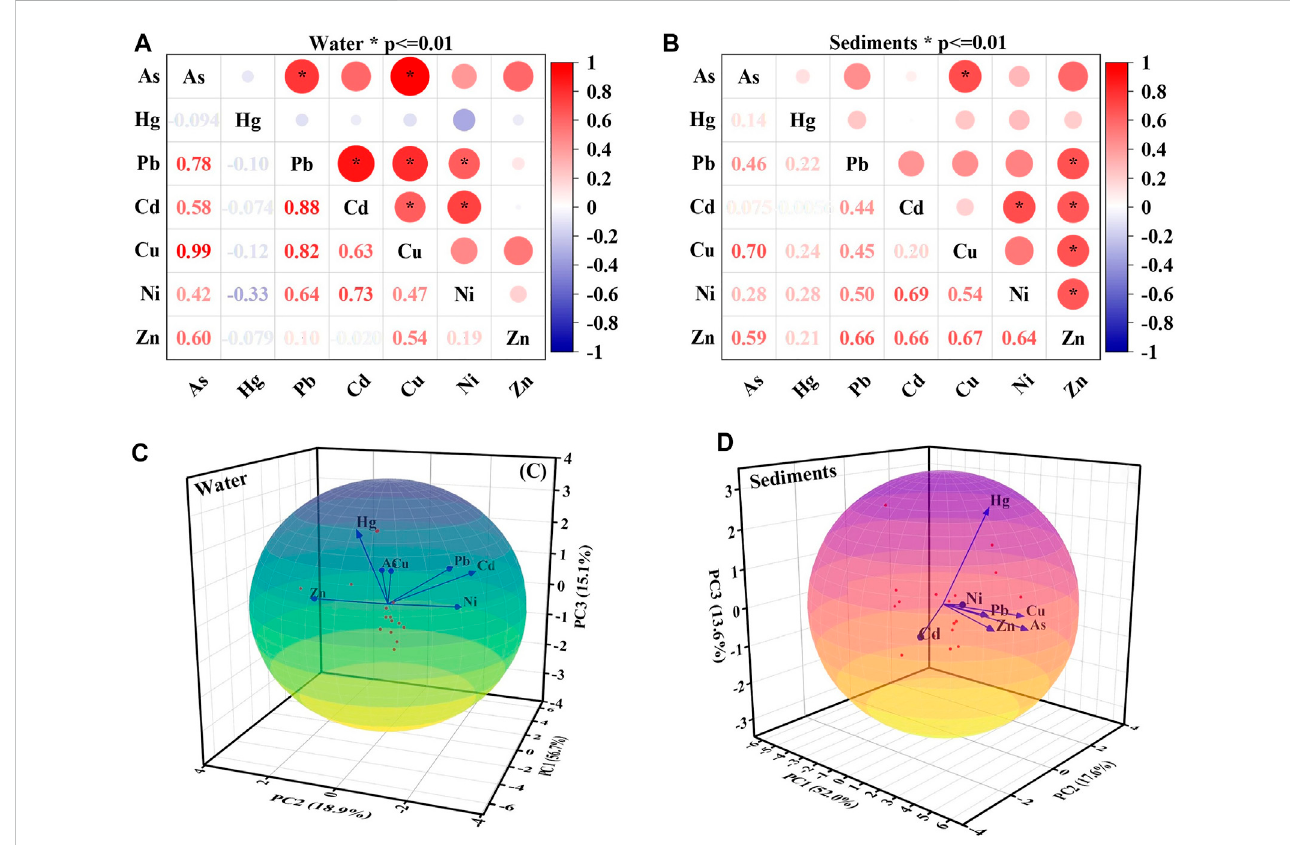
Pearson correlation (A,B) and principal component analysis (PCA) (C,D) of HMs in surface water and sediment